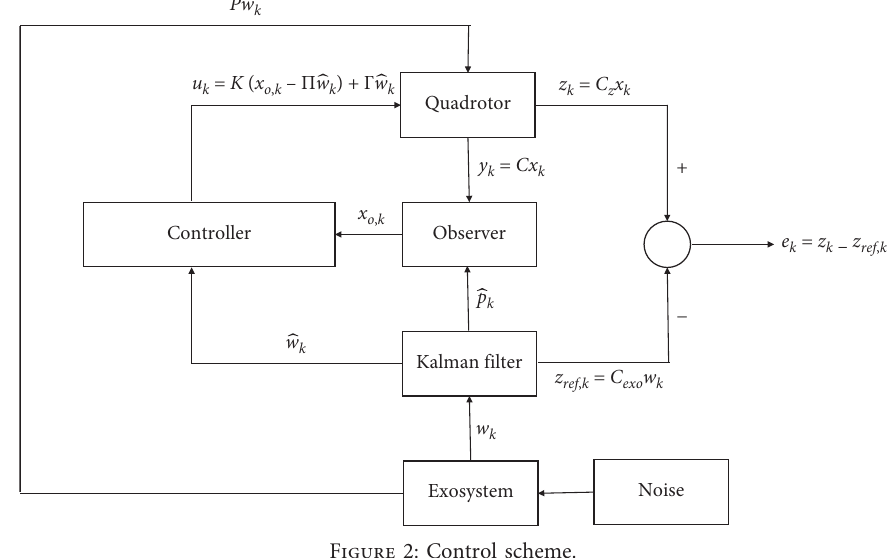
Figure 2: Control scheme.